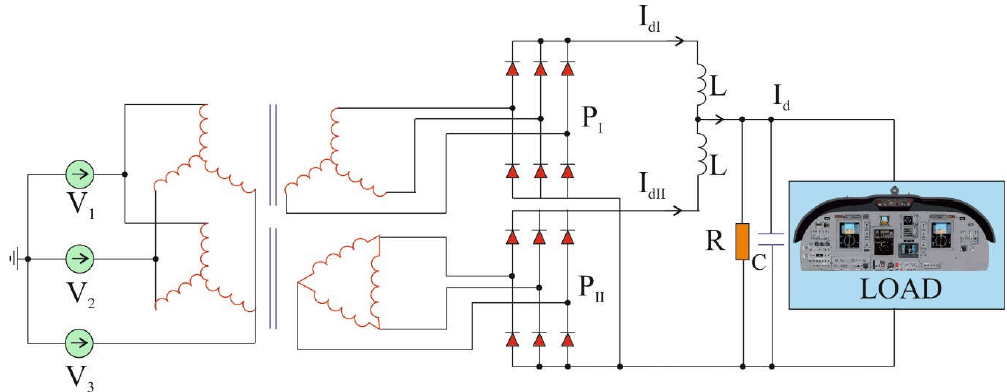
Figure 1. Diagram of a classical 12-pulse rectifier in the auto-transformer rectifier unit (ATRU) system.